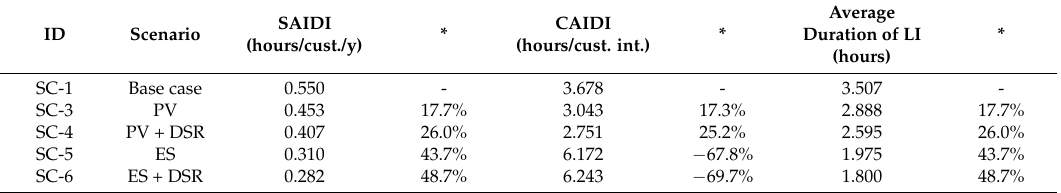
Table 5. Duration of sustained interruptions: system and customer-based